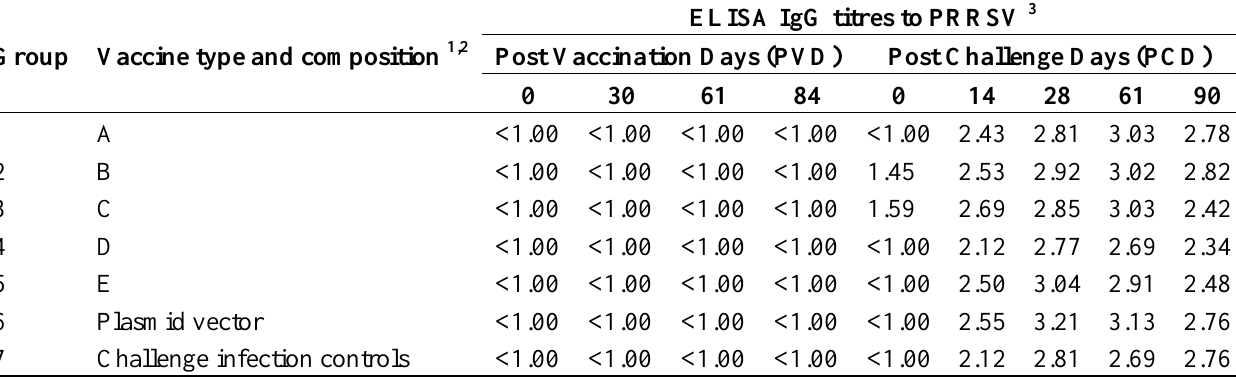
Table 6. ELISA Immunoglobulins G (IgG) response of pigs immunised with experimental PRRS DNA vaccines and challenge infected with virulent PRRSV.